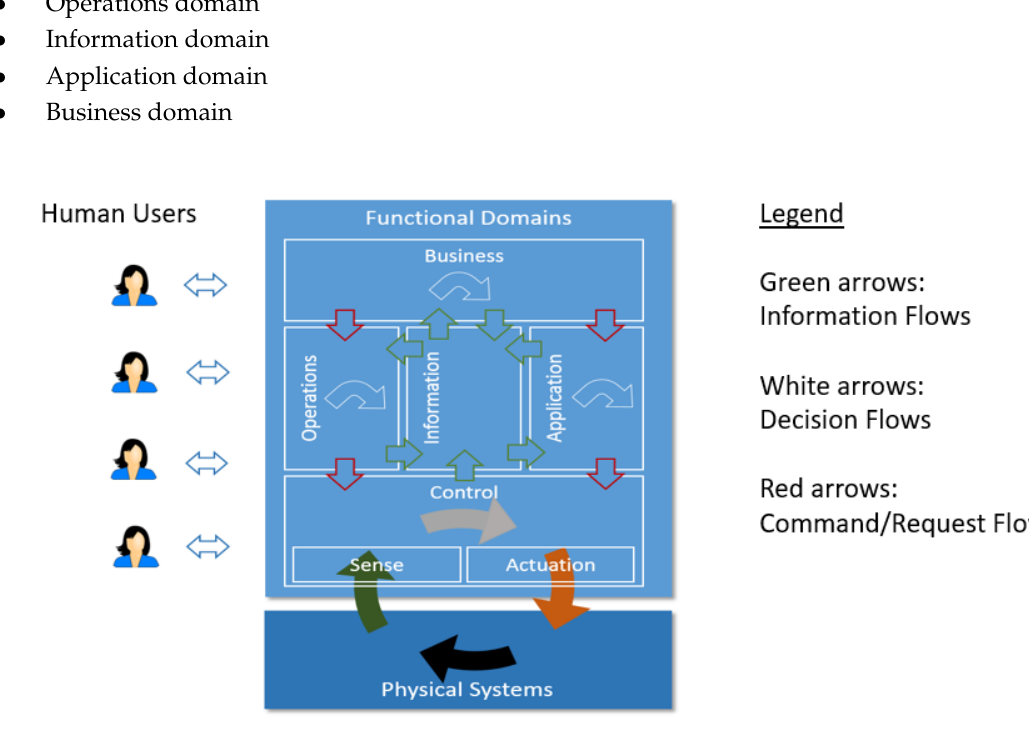
Figure 6. The Industrial Internet Reference Architecture (IIRA) functional domains [2].